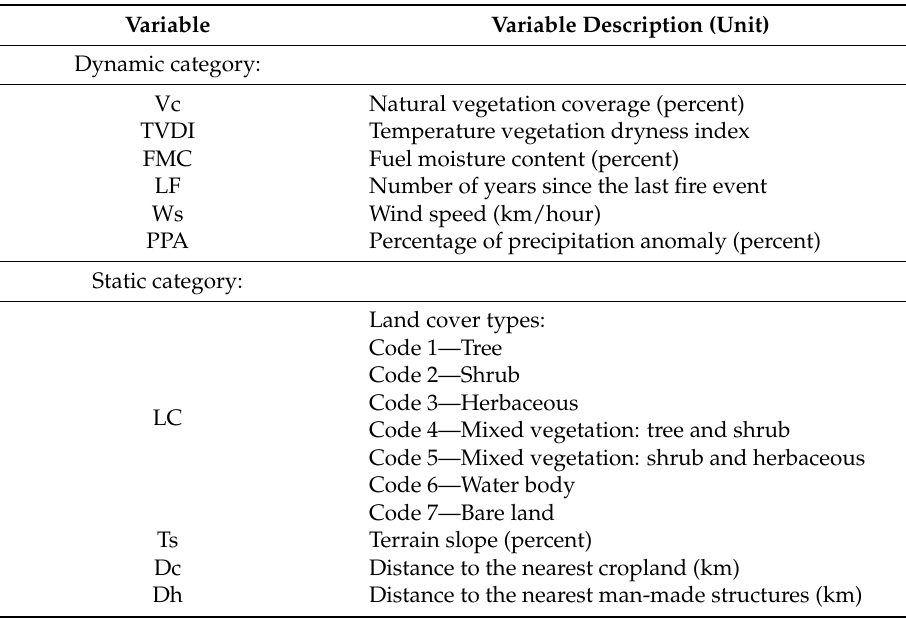
Table 2. Variables used to model wildfire occurrence in high-voltage power line corridors.